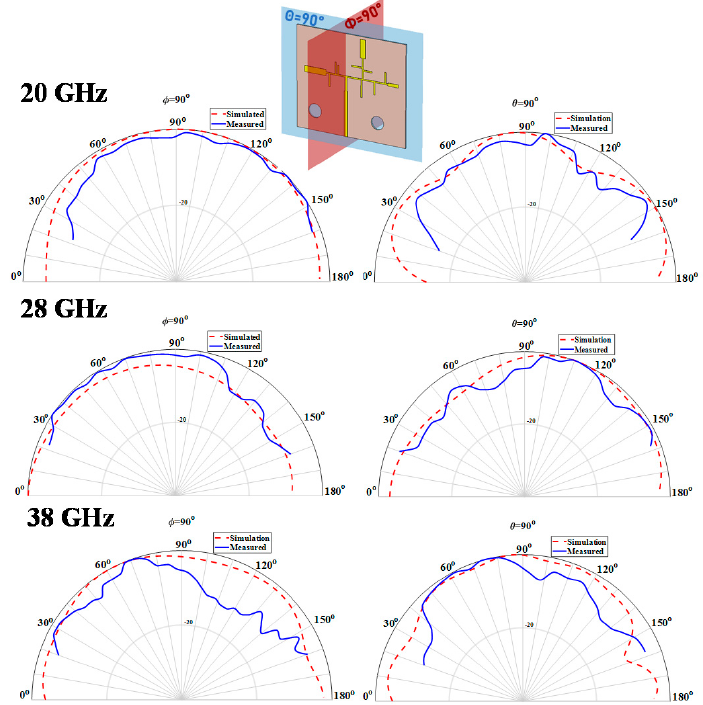
Figure 16. Simulated and Measured Normalized Radiation Pattern of the Tri-Band Antenna at 20/28/38 GHz.